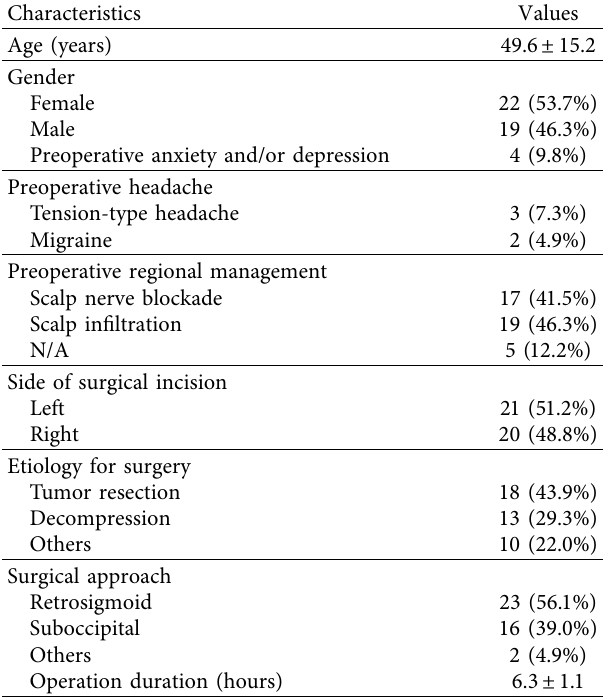
Table 2: Baseline demographics and perioperative data ( n � 41). Characteristics